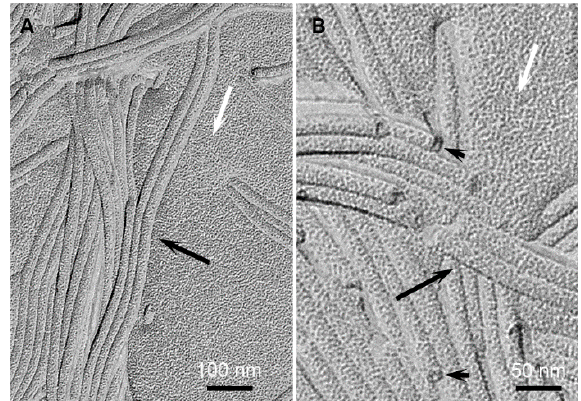
Figure 5. Freeze fractures of gels of HUB-4 in cyclohexane (2 wt.%). ( A ) large field view; ( B ) enlargement showing the end of tubes. Black arrows: tubes; arrow heads: ends of tubes; white arrows: amorphous solvent.